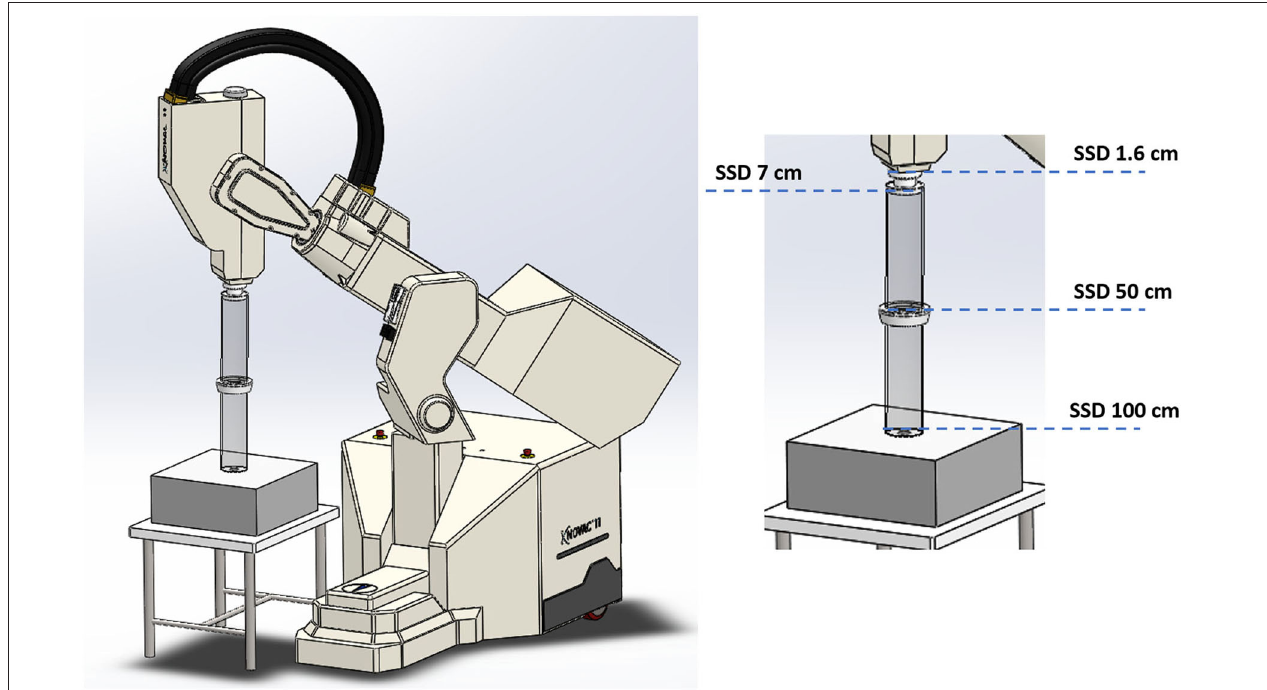
FIGURE 1 | Four collimation configurations obtained acting on Novac7 collimation system